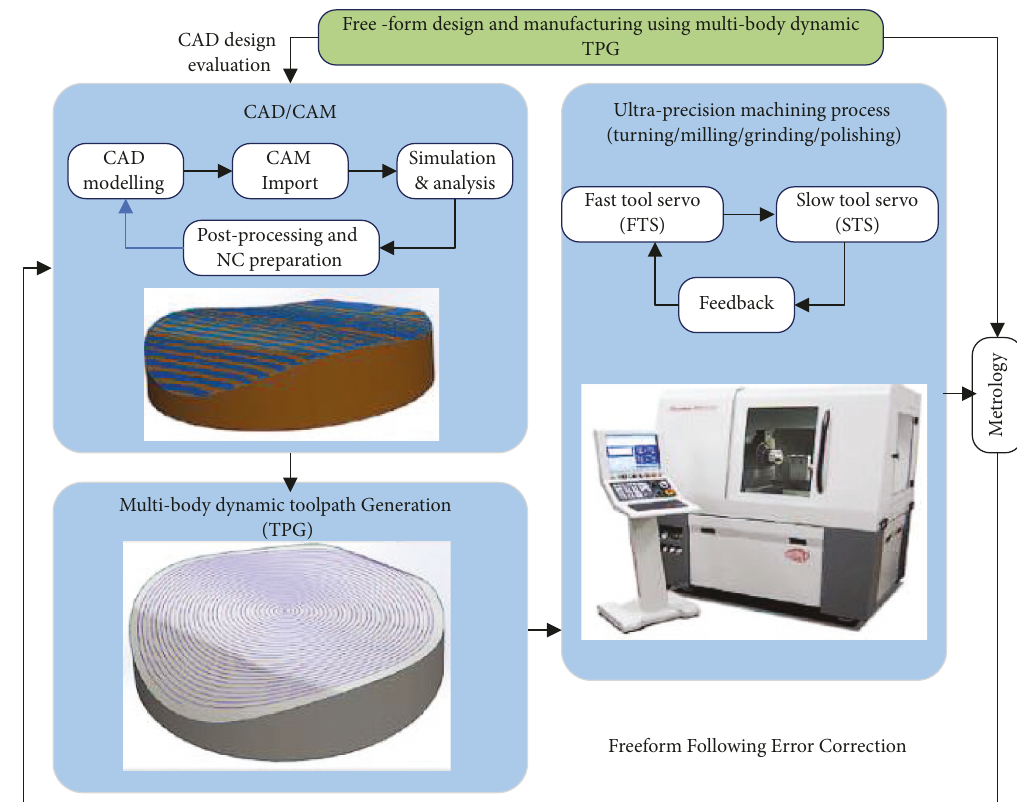
Figure 7: Ultraprecision machining principle diagram using multibody TPG [28].